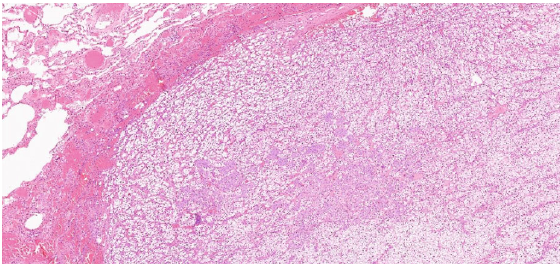
Figure 3: Microscopic examination of the basal nodule biopsy specimen (H&E, 40x). Pulmonary parenchyma (upper left corner) with involvement of epithelial cells with the clear cytoplasm and well-de fi ned cell membrane, interspersed within a highly vascularized stroma, compatible with ccRCC. Inside this, a distinct population cells, arranged in nests, with a more eosinophilic cytoplasm is identi fi ed, corresponding to the breast carcinoma.